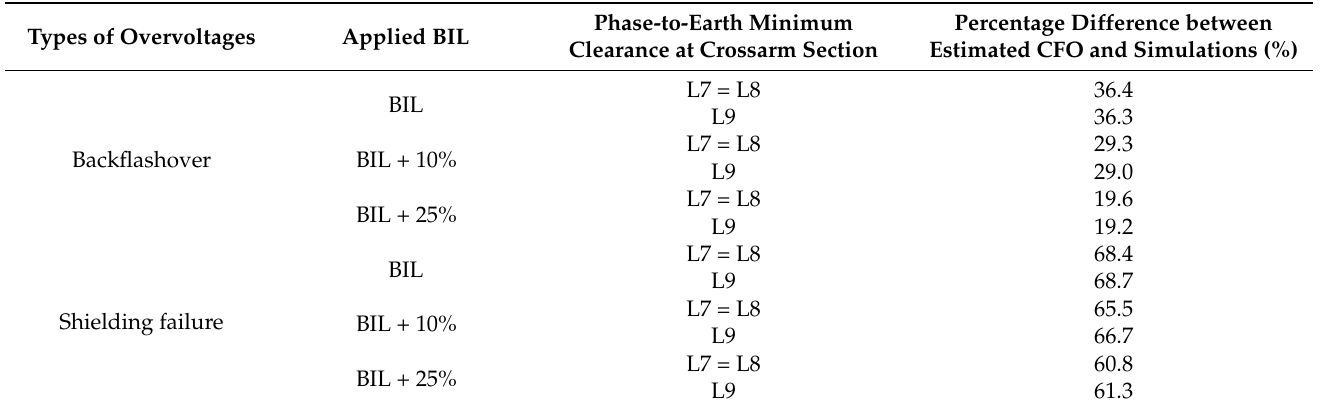
Table 12. The voltage magnitude and the percentage difference between CFO and simulation results. Types of Overvoltages Applied BIL